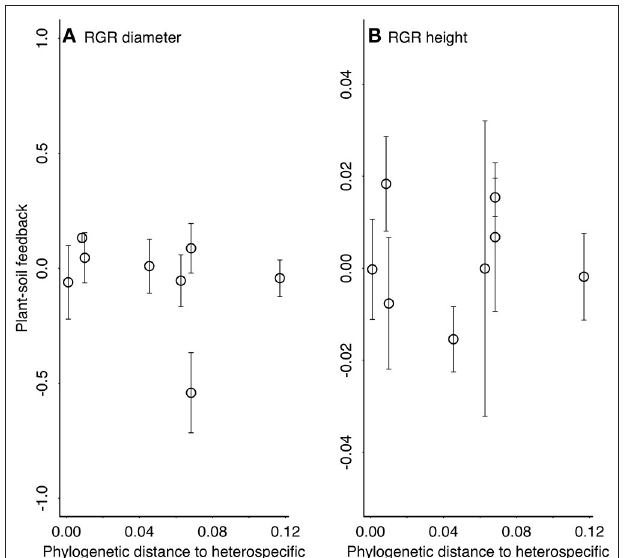
FIGURE 3 | The strength of plant-soil feedbacks [lnRR = ln(RGR conspecific/RGR heterospecific)] across the phylogenetic distance from the focal tree to the heterospecific soil inocula source ( Quercus rubra ) ( Table 2 ). Relative growth rates were used to calculate lnRR for (A) plant diameter and (B) plant height across 16 months in the field. Positive plant-soil feedbacks have positive values and negative plant-soil feedbacks have negative values of lnRR. Means ± 1 SE.